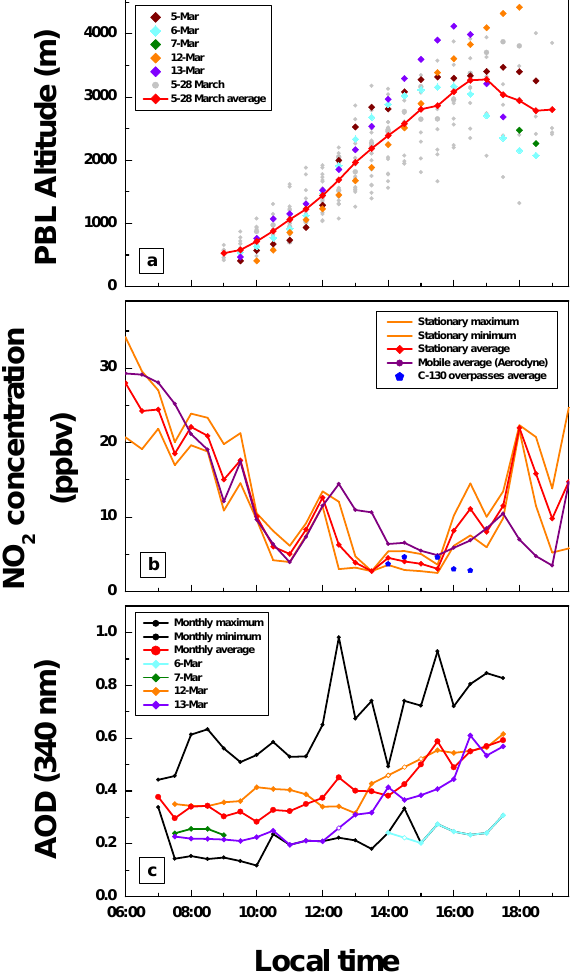
Fig. 1. Diurnal variation at T1 site of (a) PBL altitude above ground level (a.g.l.) (color symbols correspond to the cloudless days); (b) NO 2 concentration measured by a stationary instrument (6–31 March), a co-located Aerodyne mobile laboratory (19–22 March), and from the C-130 aircraft overpasses (8, 10, 18, 22, and 29 March); (c) aerosol optical depth at 340nm (AERONET, 6–31 March) (open symbols correspond to